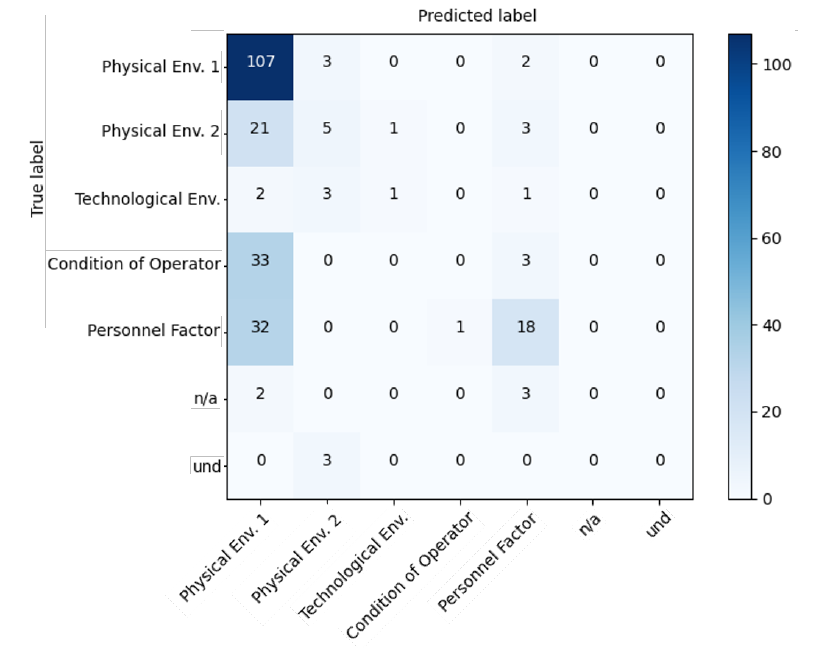
Figure 5. Precondition for Unsafe Act confusion